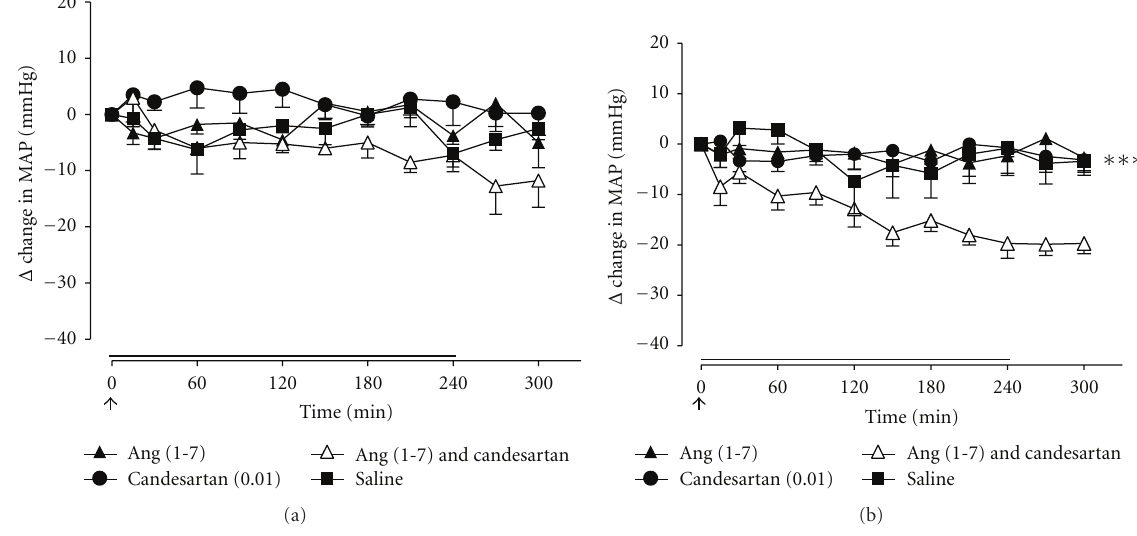
Figure 1: E ff ect of the AT 1 R Ang (1-7) (15pmol/kg/min; 4-hour infusion depicted by full line), AT 1 R antagonist, candesartan (0.01mg/kg bolus IV; depicted by an arrow), saline (0.1mL/kg 0.9% NaCl IV for 4 hours), and Ang (1-7) + candesartan on MAP in (a) adult WKY rats ( n = 4) and (b) aged WKY rats ( n = 7). Values represent mean ± SEM. ∗∗∗ P < 0 . 001, for treatment e ff ect of Ang (1-7) + candesartan versus all other treatments (2-way RM ANOVA).